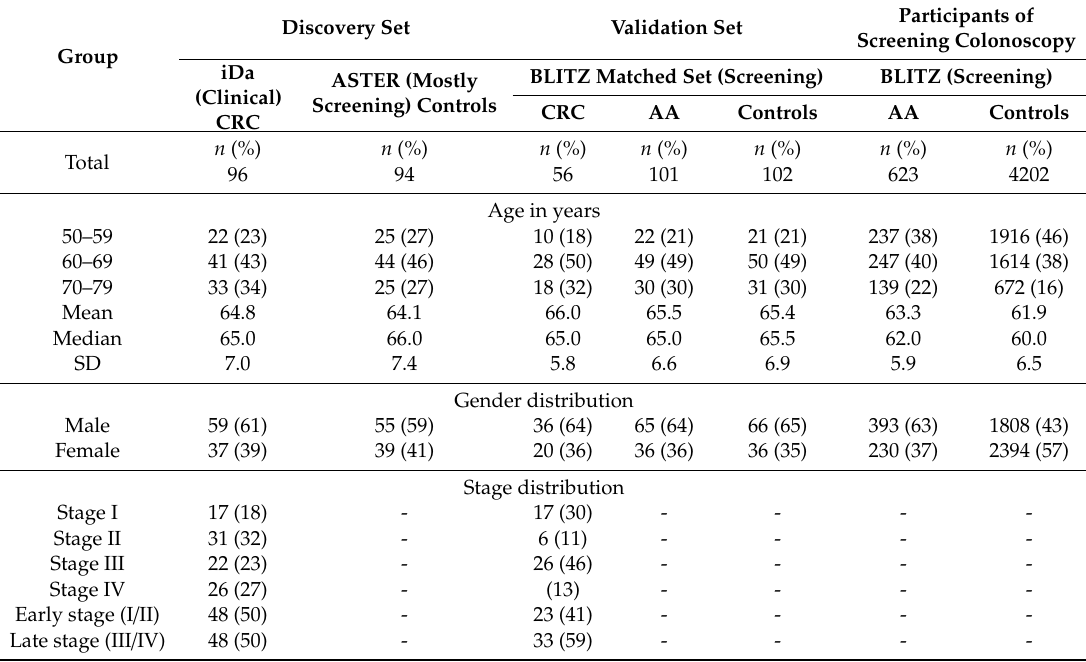
Table 1. Characteristics of the study